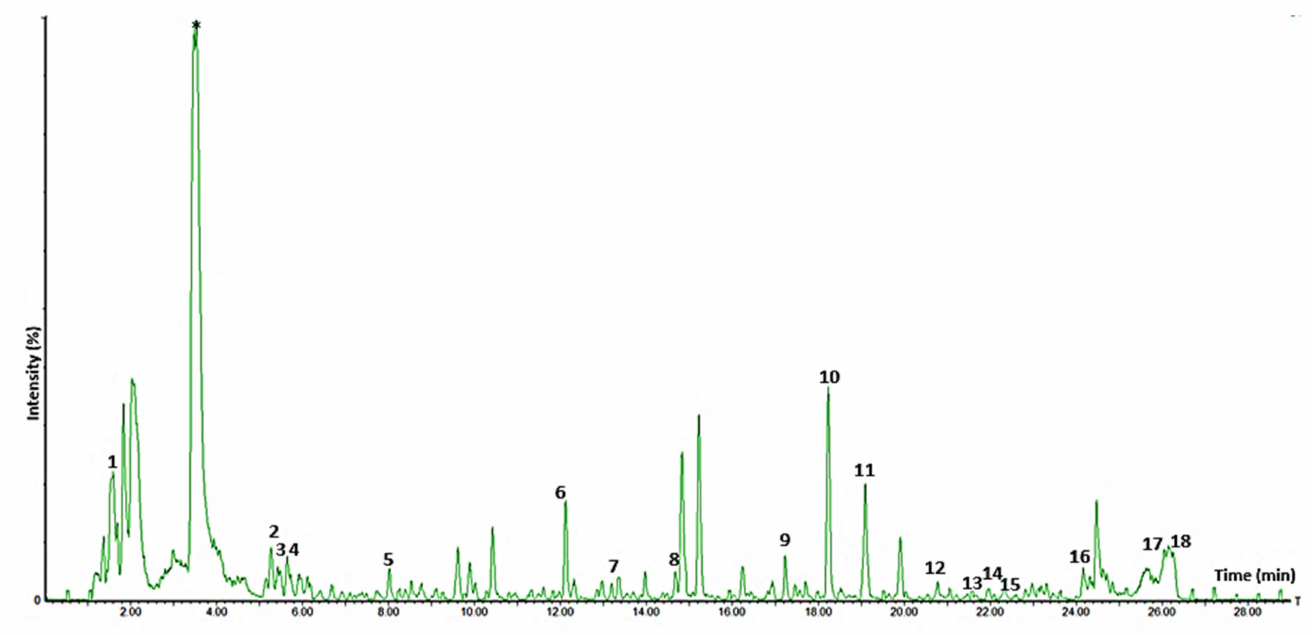
Figure 5. A typical liquid chromatography mass spectrometry (LC-MS) chromatograph of the